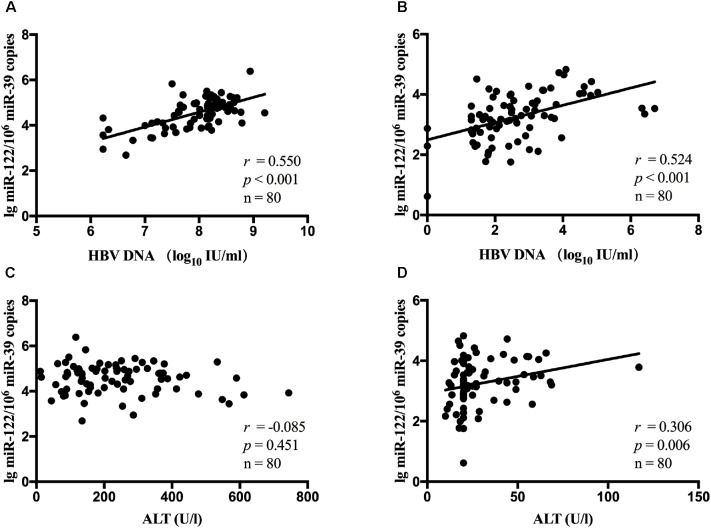
The correlation between serum miR-122 levels, viral loads and ALT levels in all patients. Spearman’s correlations of serum miR-122 levels and HBV DNA levels were conducted at baseline (A) and week 24 (B). Spearman’s correlations of serum miR-122 levels and ALT levels were conducted at baseline (C) and week 24 (D).